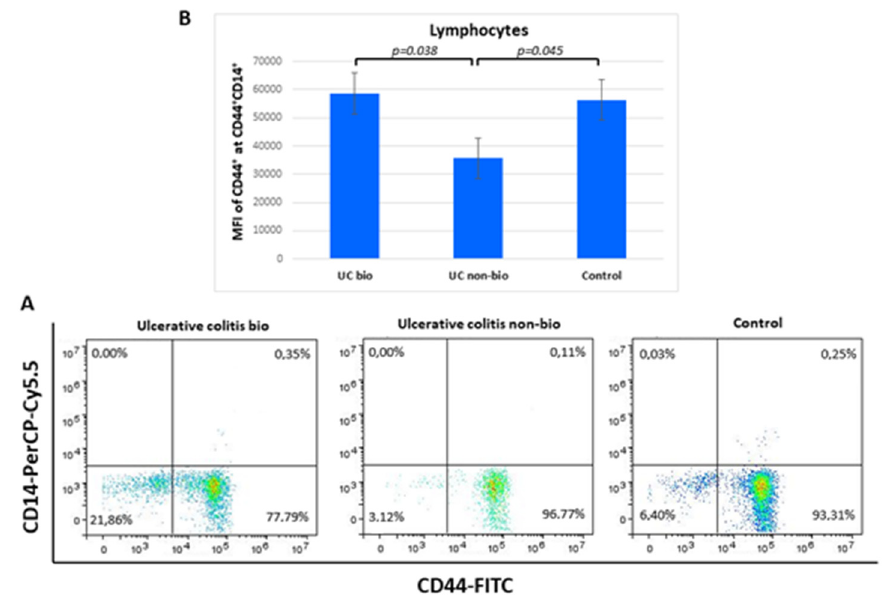
Figure 3. MFI of CD44 on CD14 + CD16 ++ monocytes in IBD biological therapy treated patients and control subjects. MFI, median fluorescence intensity; UC, ulcerative colitis.